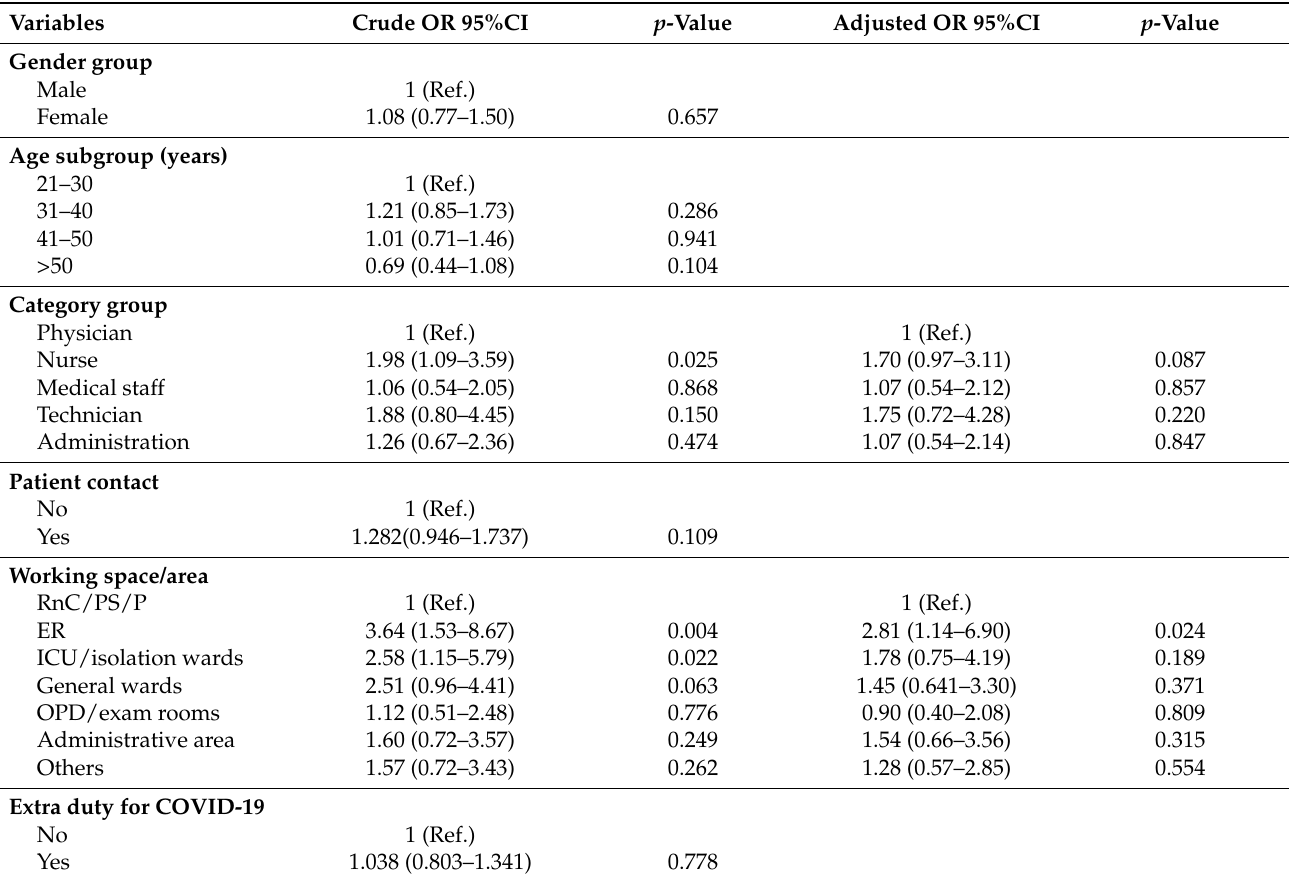
Table 3. Investigation of the risk of moderate to severe mood